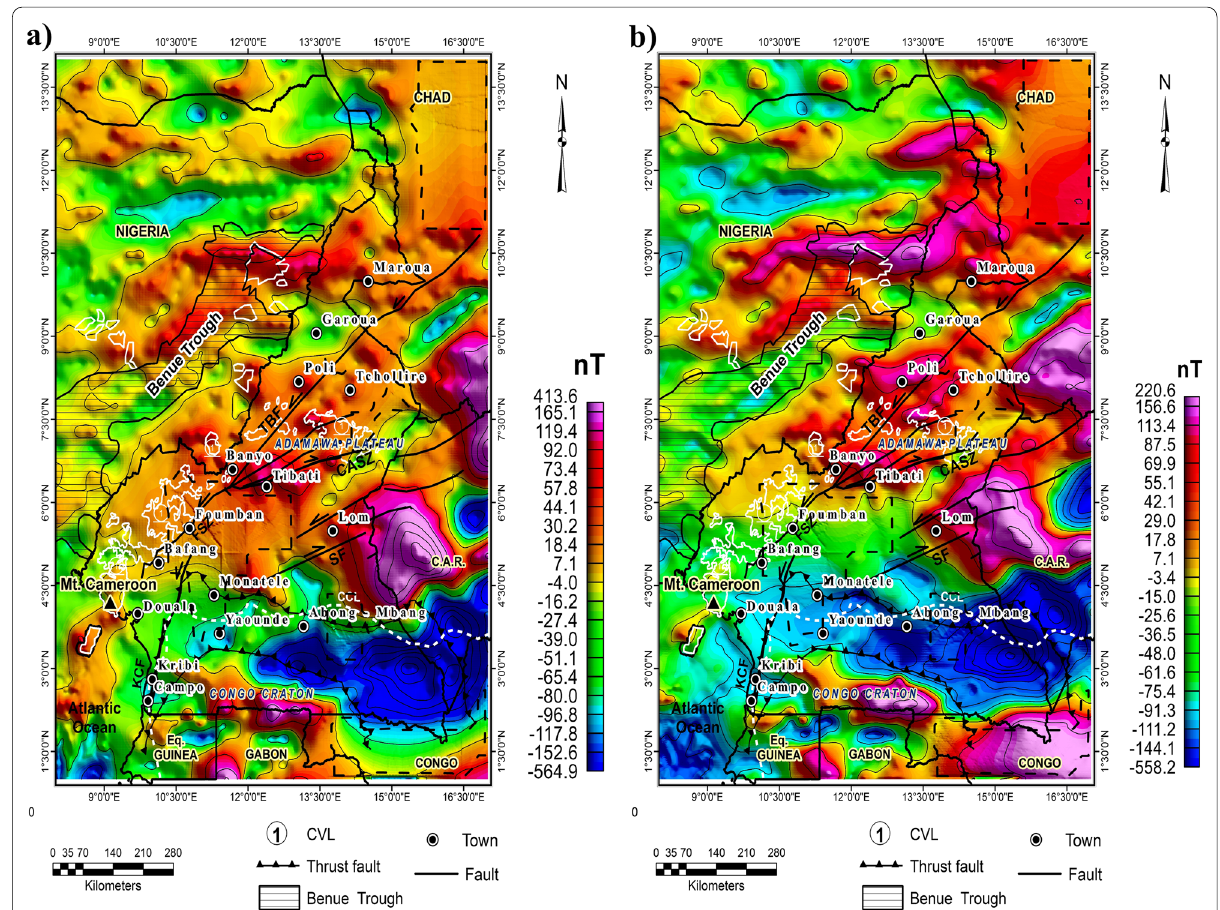
Fig. 4 a Total magnetic intensity map (TMI); b reduced to the equator of total magnetic intensity map (RTE–TMI). Black dashed contours are the areas lacking experimental data and filled by interpolation using the kriging